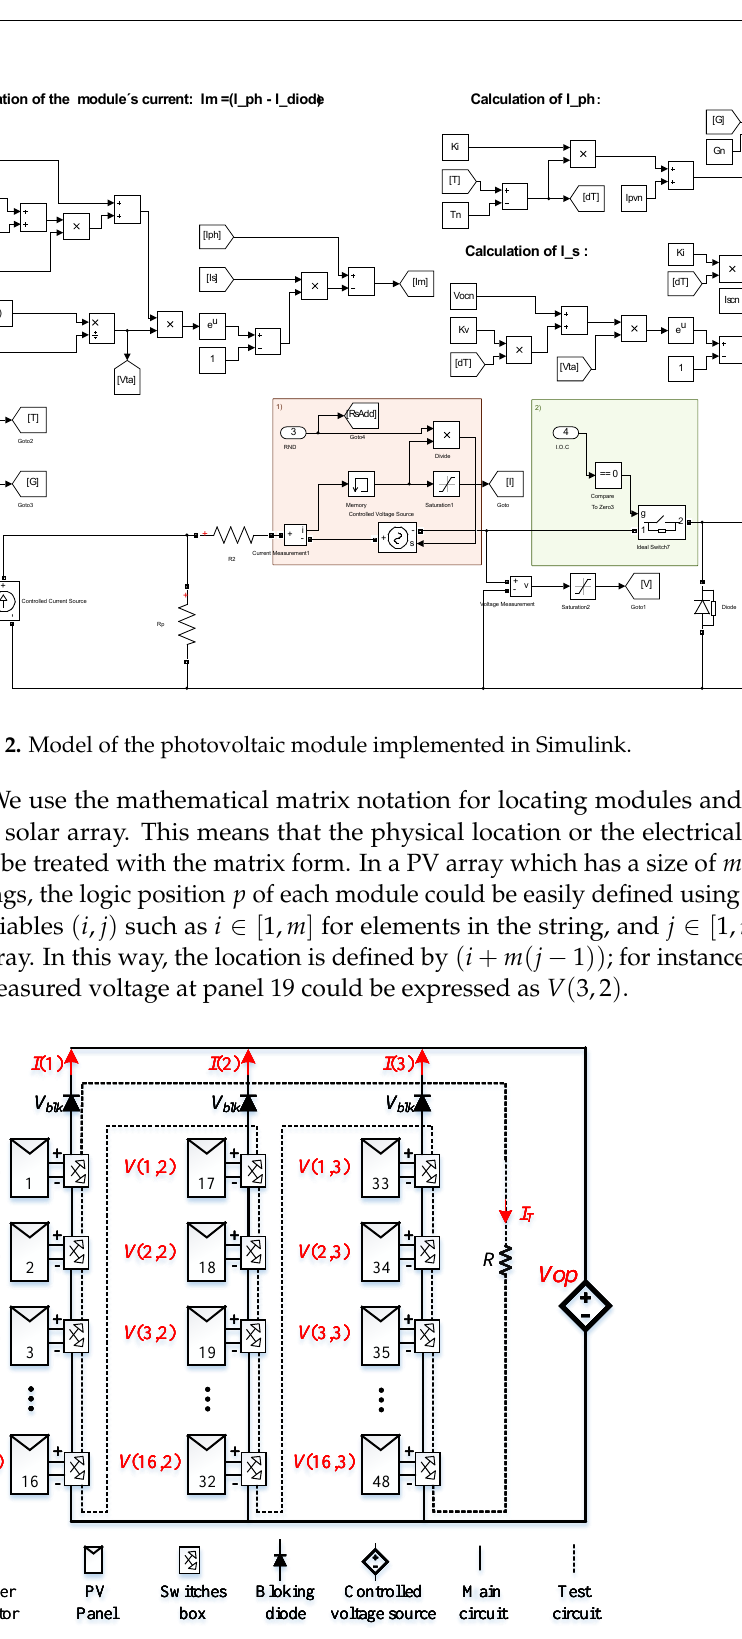
Figure 3. Photovoltaic array schematic. The electrical measurements are indicated in red color, and the distributed switch boxes for fault reconfiguration are next to the PV